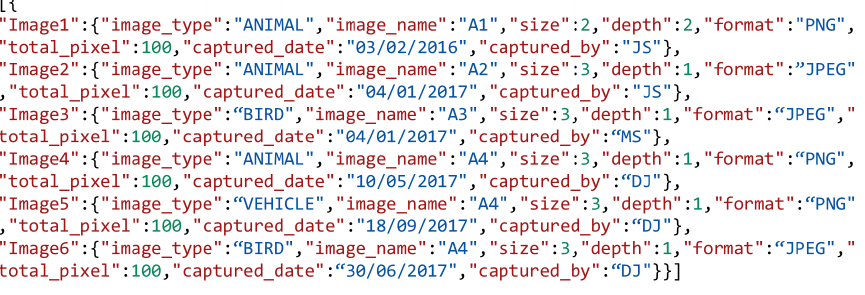
Figure 5. Example JSON document for Image metdata.